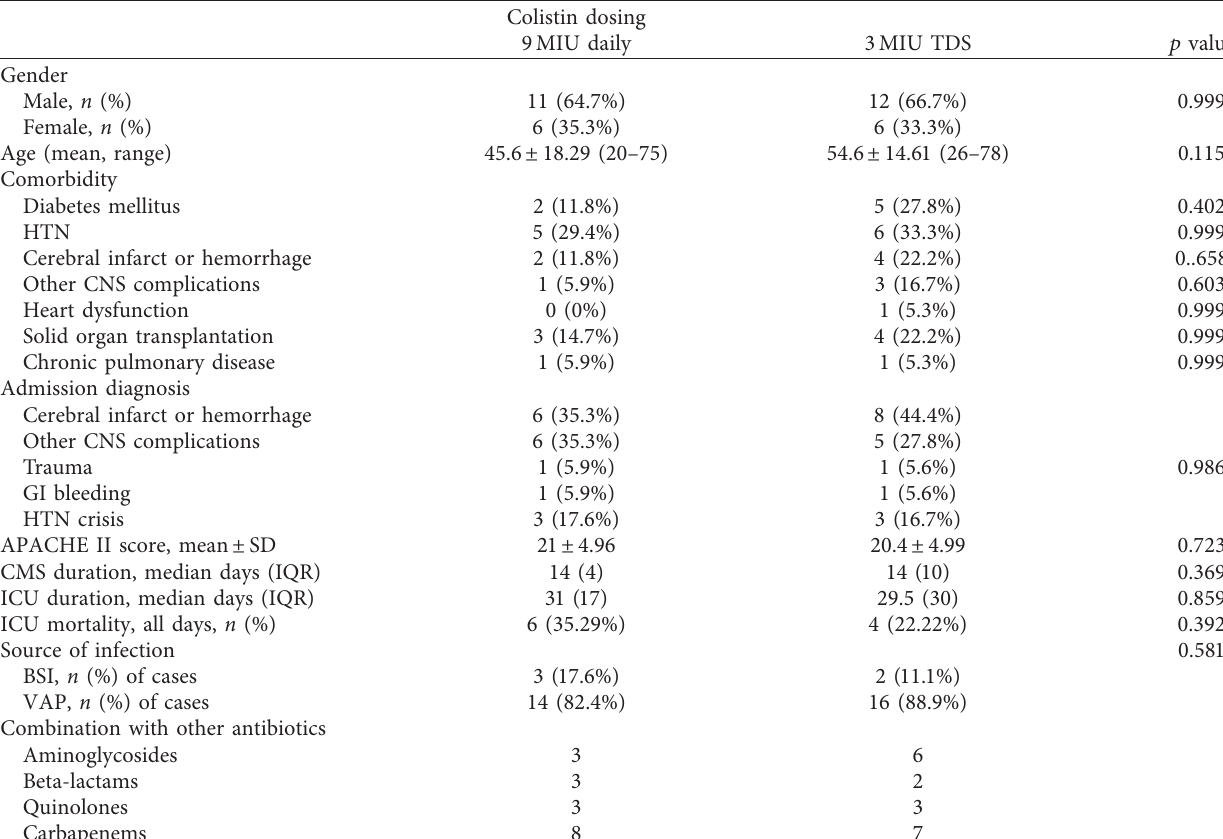
Table 1: Patients’ characteristics data.